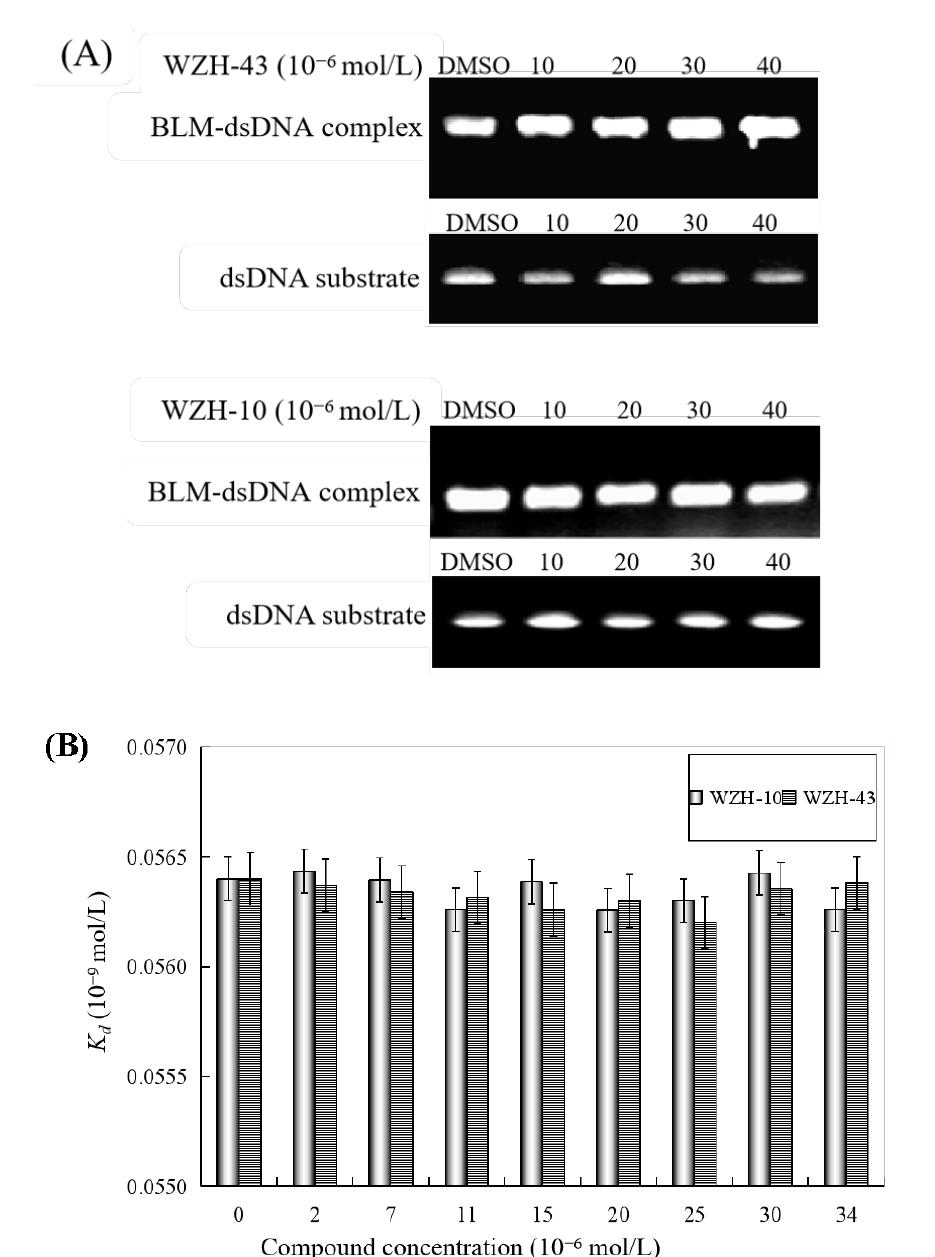
Figure 6. Effect of the two prenylated chalcones on the DNA-binding activity of BLM helicase. ( A ) Effect of WZH-43 and WZH-10 on the DNA-binding activity of the helicase by EMSA. ( B ) Effect of WZH-43 and WZH-10 on the K d values of the helicase and DNA substrate. 2.5. Effect of the Two Prenylated Chalcones on the DNA-Unwinding Activity of BLM Helicase of the two compounds (0.4 µ mol/L), indicating the promotion of DNA unwinding activity by the two prenylated chalcones at concentrations lower than 0.4 µ mol/L. However, the